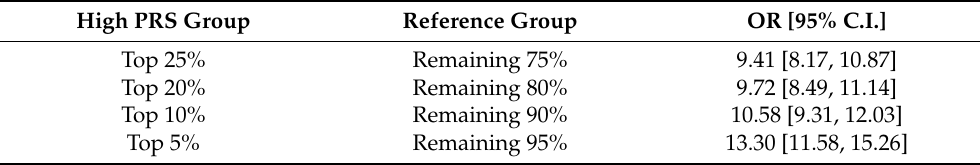
Table 5. Risk of developing glaucoma for high groups with high polygenic risk score (PRS) group. High PRS Group